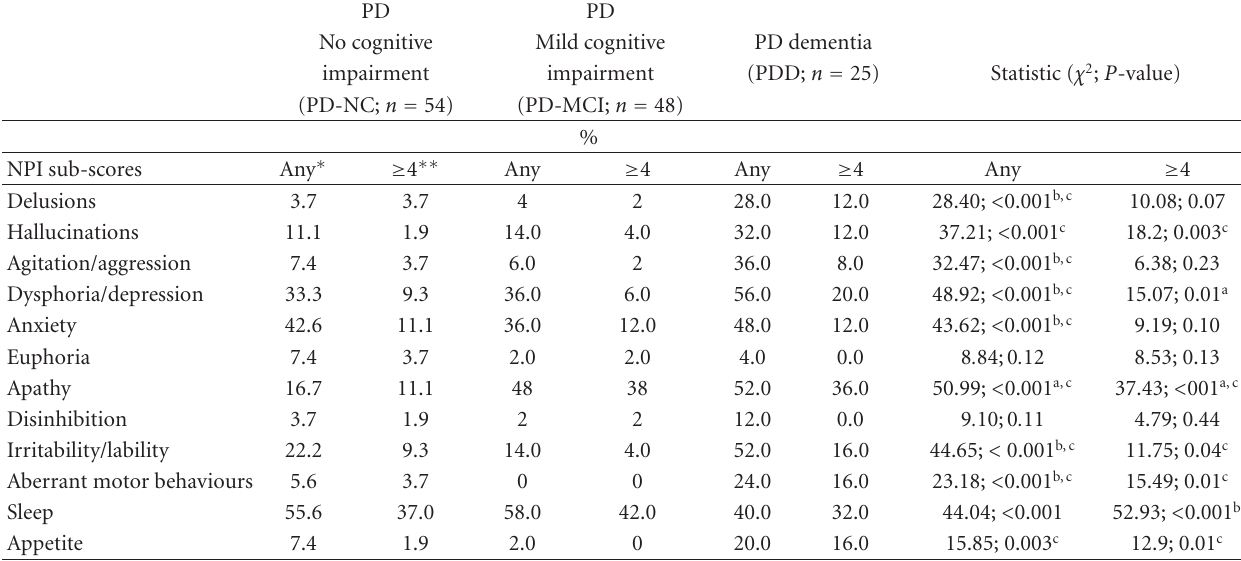
Table 5: Proportion of Neuropsychiatric Inventory (NPI) domains endorsed by the three PD groups.